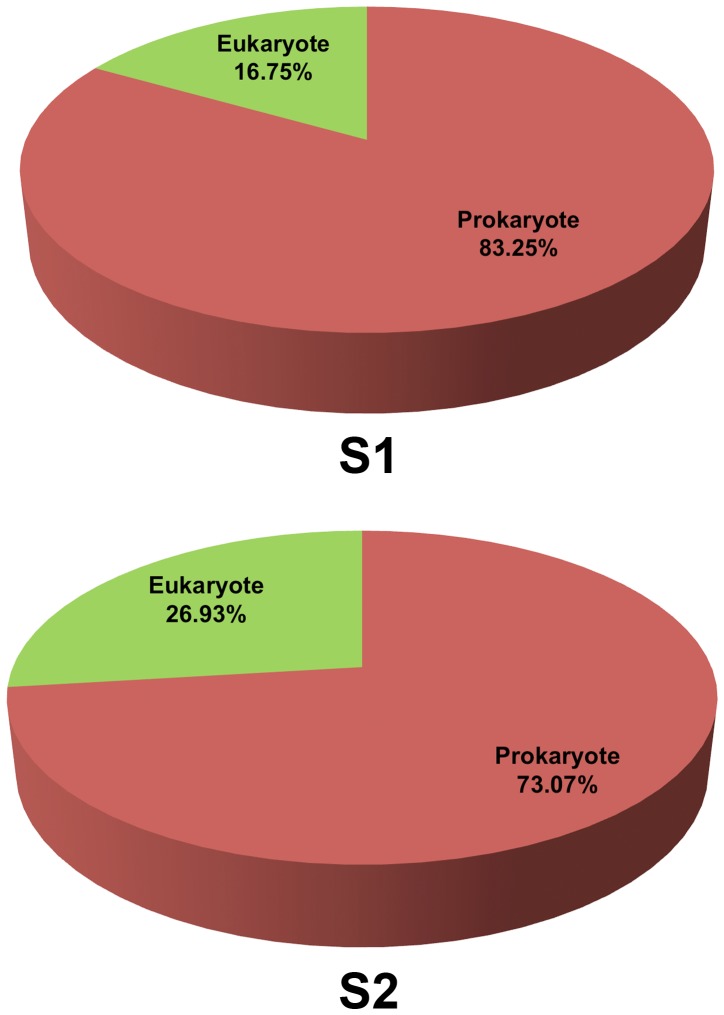
Percentages of prokaryotic and eukaryotic domains in S1 and S2.